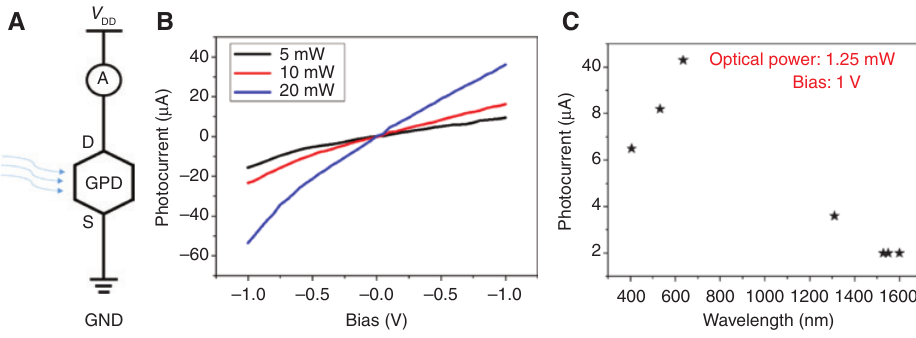
Figure 5: Static photoresponse of optical receivers. (A) Schematic measurement circuitry for static photoresponse features of GPDs. (B) Photocurrents of GPD versus bias voltages for different input optical powers at 1550 nm were shown. (C) Broadband photoresponse of GPD was investigated by using light sources with different wavelengths.